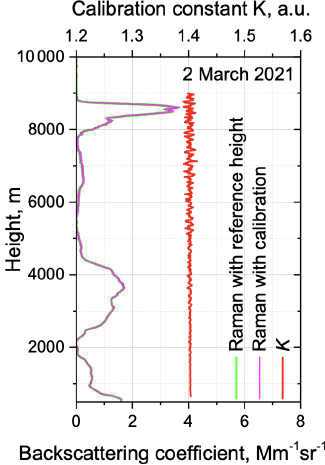
Figure 1. Backscattering coefficients at 532nm for the period 19:00–20:00UTC on 2 March 2021, calculated from Mie–Raman observations, using the same reference height as Ansmann et al. (1992; green) or the calibration constant as in Eq (5) (magenta). The profile of the calibration constant K is shown with a red